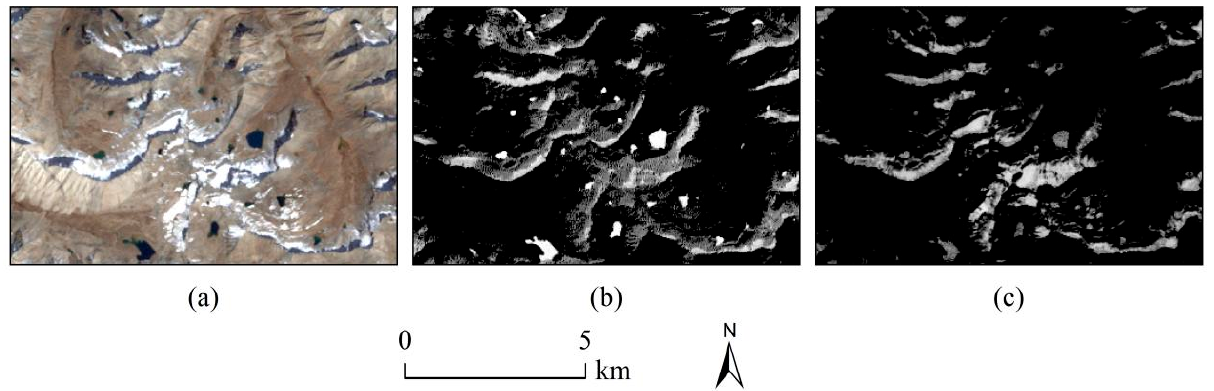
Figure 6. Water index image of Landsat TM image: ( a ) Landsat TM image; ( b ) NDWI image; ( c ) MNDWI image.